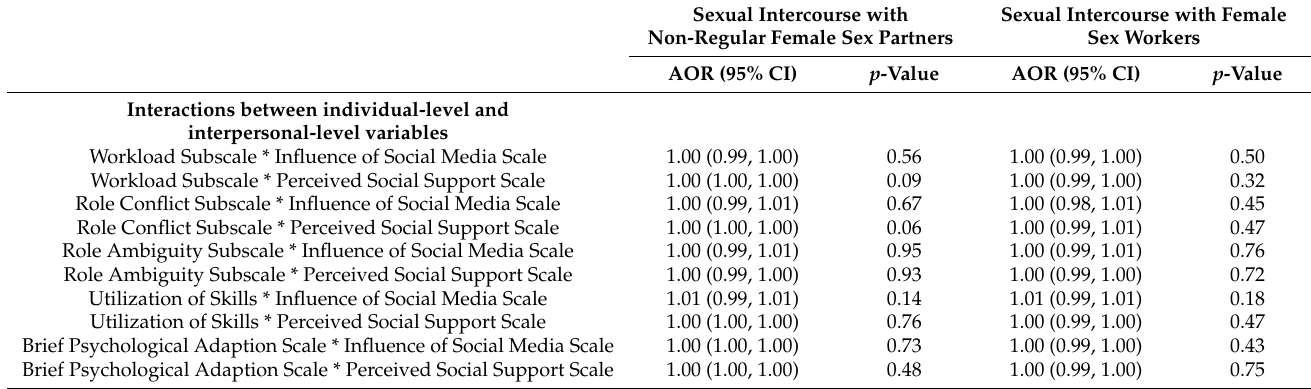
Table A1. Interactions between independent variables at different